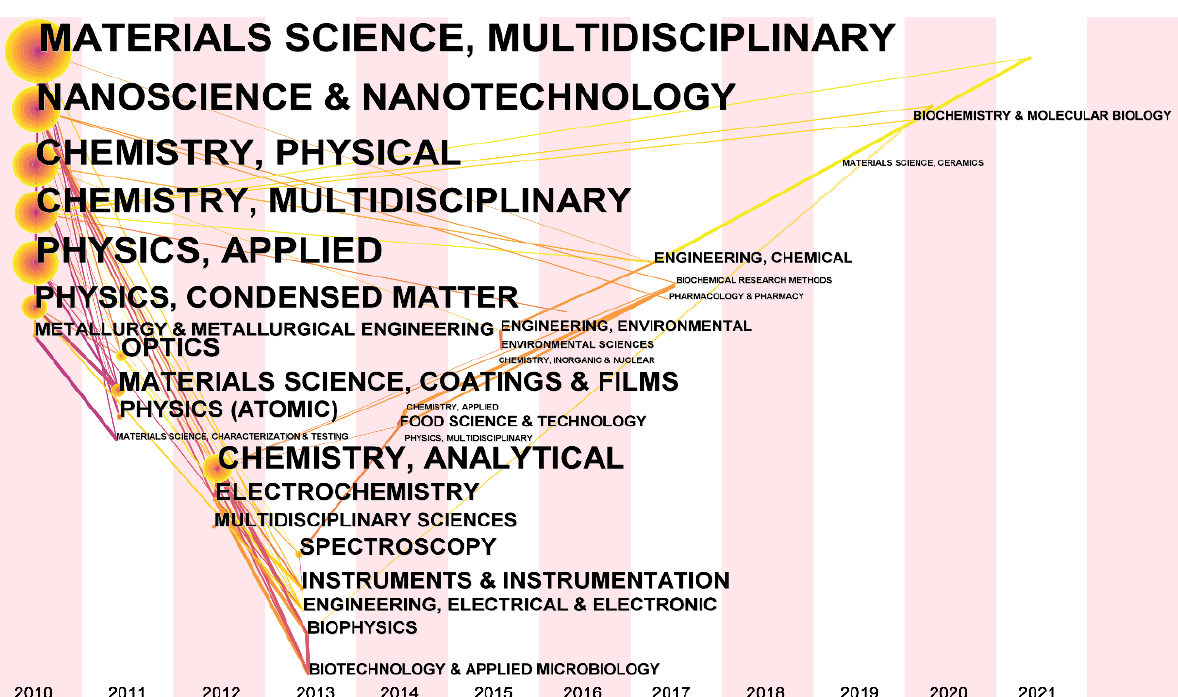
Figure 4. A time ‐ zone view of research categories for graphene ‐ based